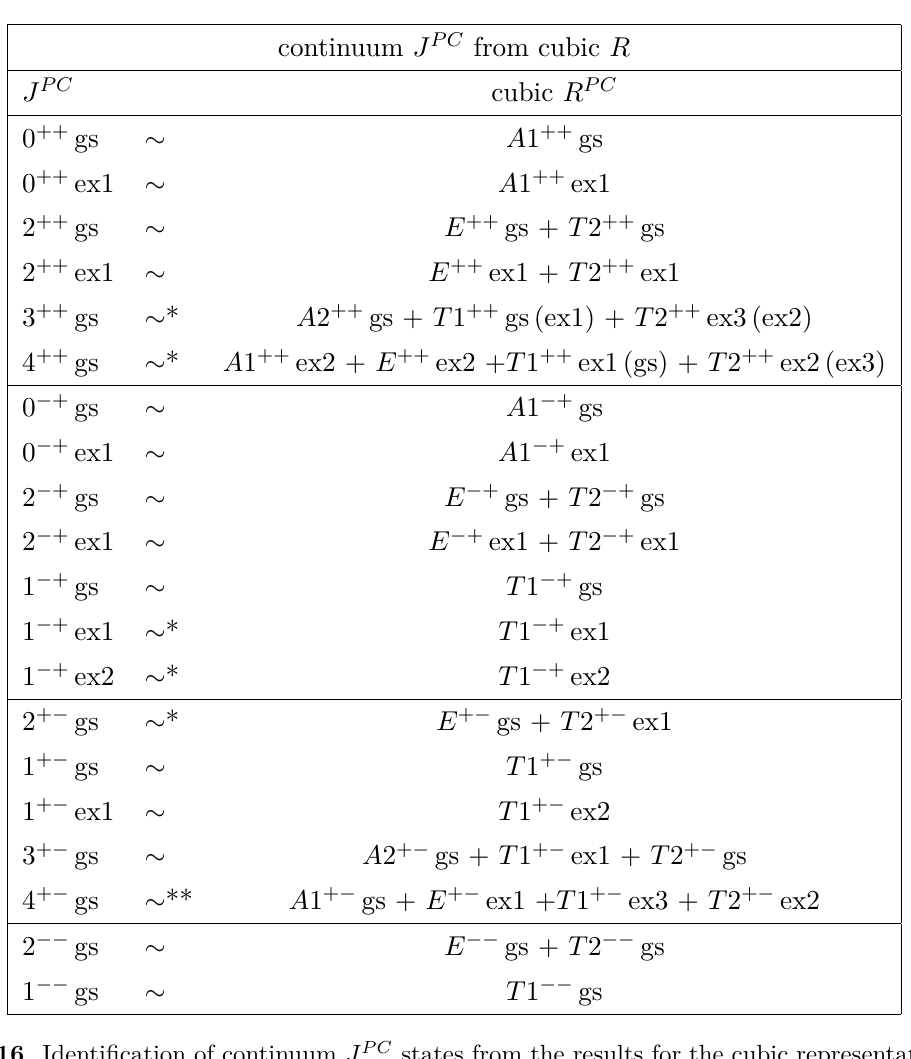
Table 16 . Identification of continuum J PC states from the results for the cubic representations in table 14. Ground state denoted by gs , i ’th excited state by exi . Where there is some ambiguity, a single star denotes ‘likely’ while two stars indicate ‘significant